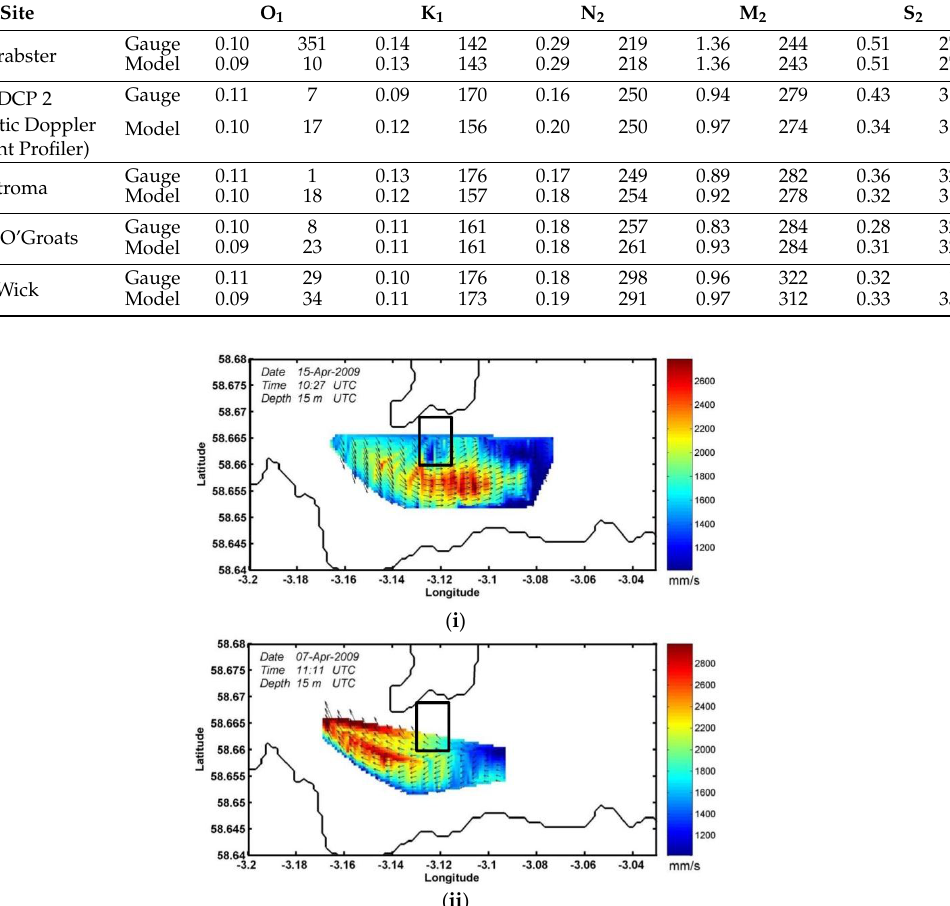
Table 1. Modelled and observed amplitude (m) and phase ( ˝ ) of the tidal height for the five principal tidal constituents at five locations around the Pentland Firth (see Figure 1).